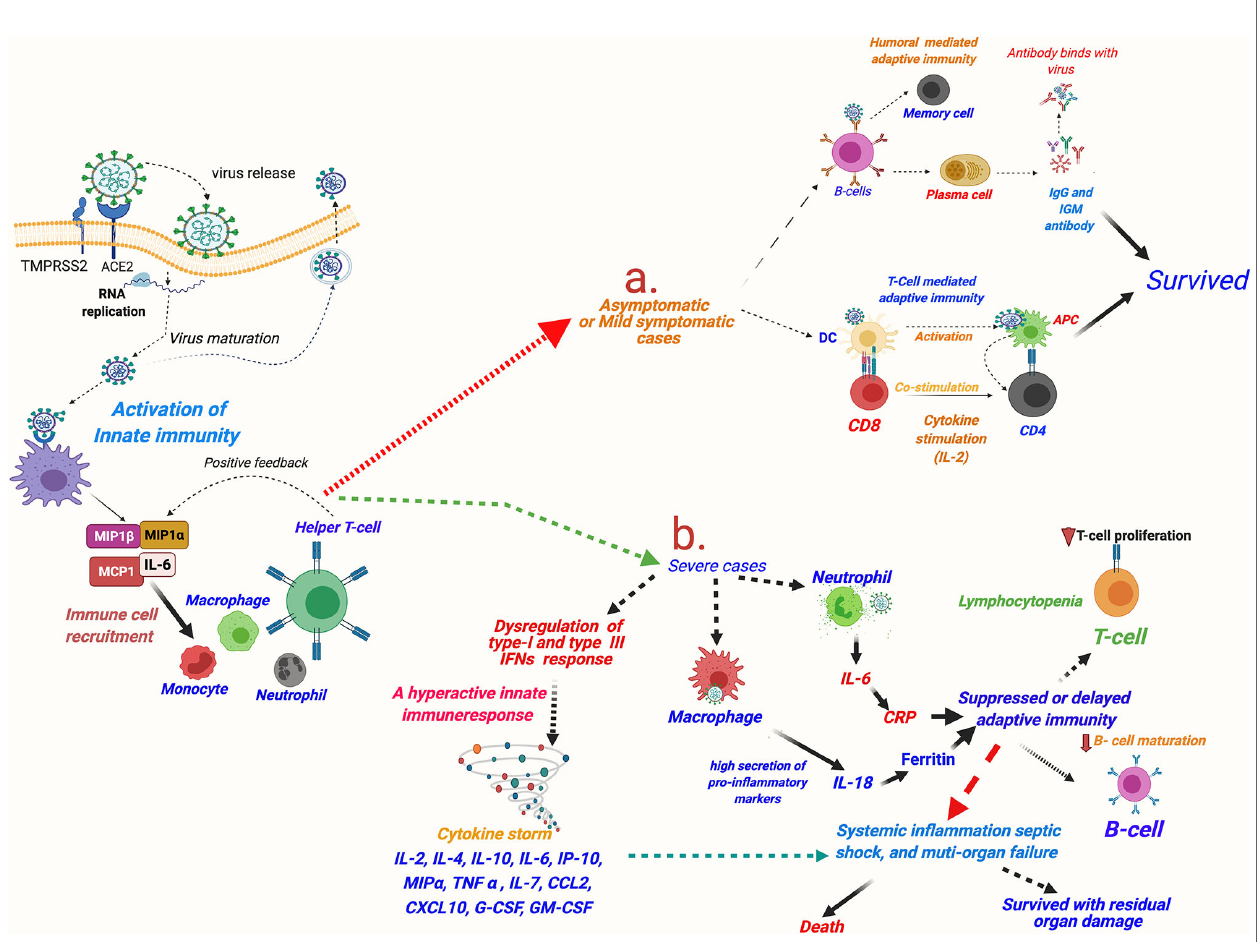
FIGURE 5 | A schematic description of immune responses in asymptomatic and mildly symptomatic and severe cases of COVID-19. SARS-CoV-2 invasion mediated by host cell entry receptor and entry-associated proteases leads to activation of innate immune response and recruitment of circulating immune cells in lung epithelium. Furthermore, immunological response is varied in asymptomatic/mildly symptomatic and severe cases of COVID-19 patients: (A) asymptomatic and mildly symptomatic cases, an optimum activation of T-cell and humoral-mediated adaptive immune response leads of cure of the patients; (B) in severe cases, a hyperactive innate immune response leading to cytokine storm and consequently killing of T cells and delayed/or suppressed B cell-mediated humoral response resulting in very poor patient outcomes is observed. MIP, macrophage in fl ammatory protein; MCP, monocyte chemoattractant protein; IL, interleukin; G-CSF, granulocyte colony-stimulating factor; GM-CSF, granulocyte-macrophage colony-stimulating factor; IFN, interferon; TNF- a , tissue necrosis factor- a ; CCL2, chemokine (C-C motif) ligand 2; CXCL10, chemokine (C-X-C motif) ligand-10; COVID-19, coronavirus disease 2019; SARS-CoV-2, Severe acute respiratory syndrome coronavirus